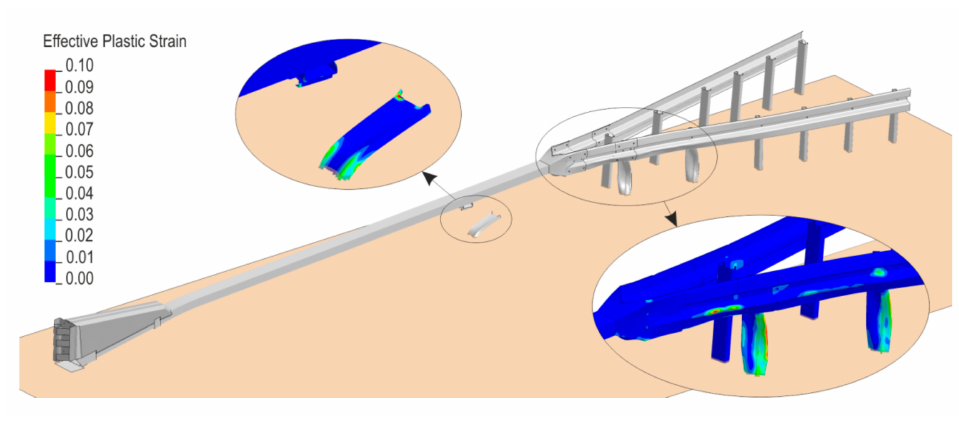
Figure 8. Deformation of the system.